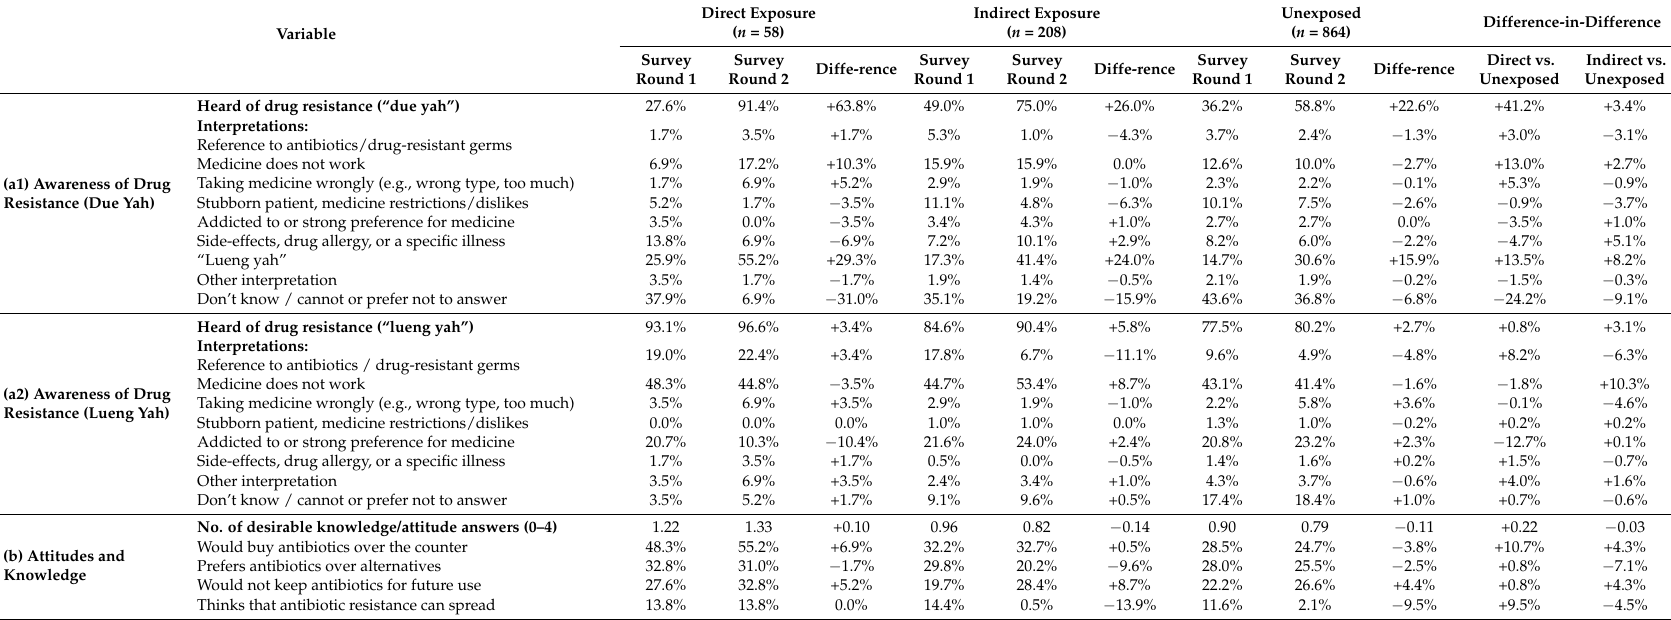
Table 6. Antibiotic-related attitudes and knowledge across survey